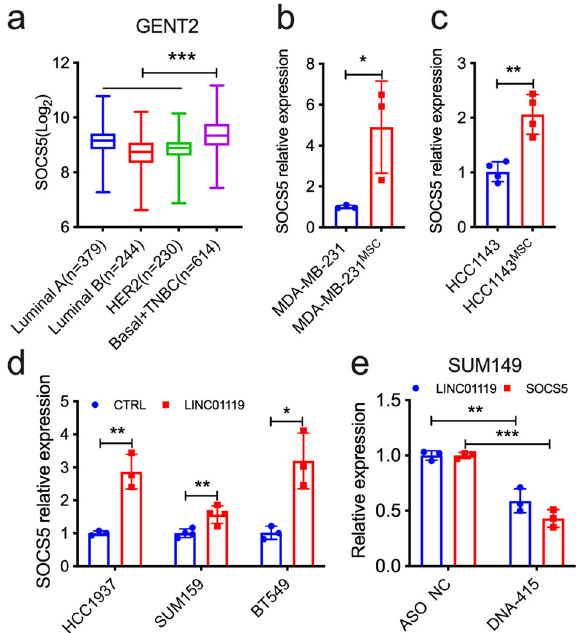
Fig. 5 LINC01119 regulates SOCS5. a SOCS5 levels in clinical breast cancer from GENT2 database analyzed by SAMs. Box-and-whisker plots represent the median (centerline) and inter-quartile range (IQR; box). The whiskers extend up to 1.5 times the IQR from the box to the smallest and largest points. b , c qRTPCR measurements of SOCS5 levels in the indicated MDA-MB-231 MSC ( b ) and HCC1143 MSC ( c ) cells. d qRTPCR measurements of SOCS5 in the indicated HCC1937, SUM159, and BT549 cells stably over-expressing LINC01119. e qRTPCR measurements of LINC01119 and SOCS5 in SUM149 cells 48 h after transfection with control or anti-LINC01119 ASOs. For analyses in b – e , mean ± SD of n = 3 are